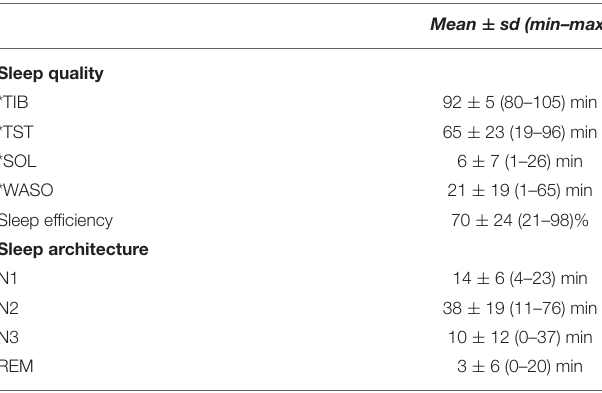
TABLE 1 | Means, standard deviations of participants’ sleep quality, and architecture